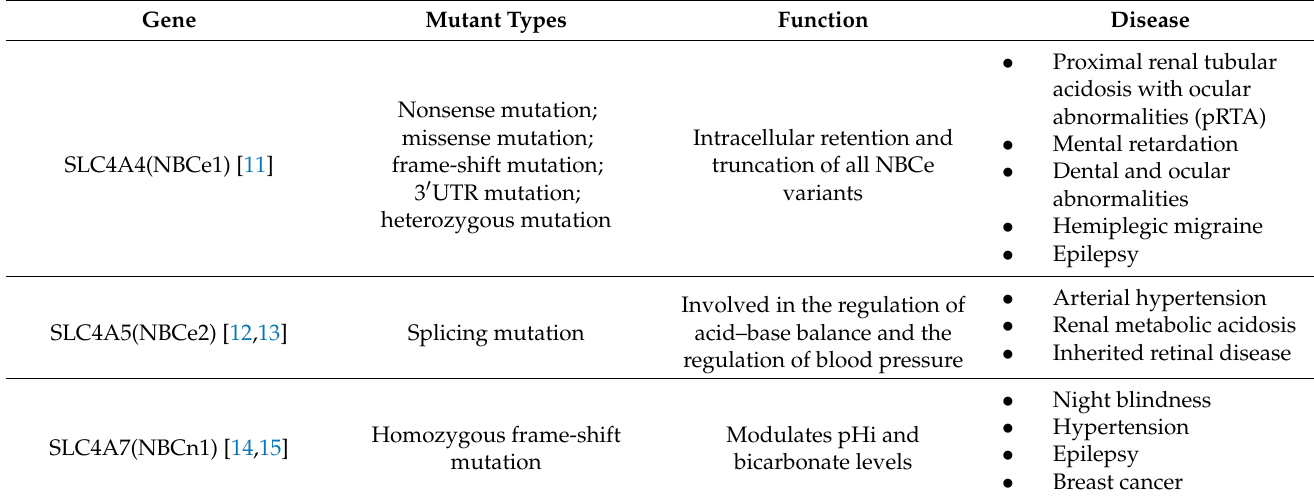
Table 1. SLC4-linked HCO 3 − transporter-related